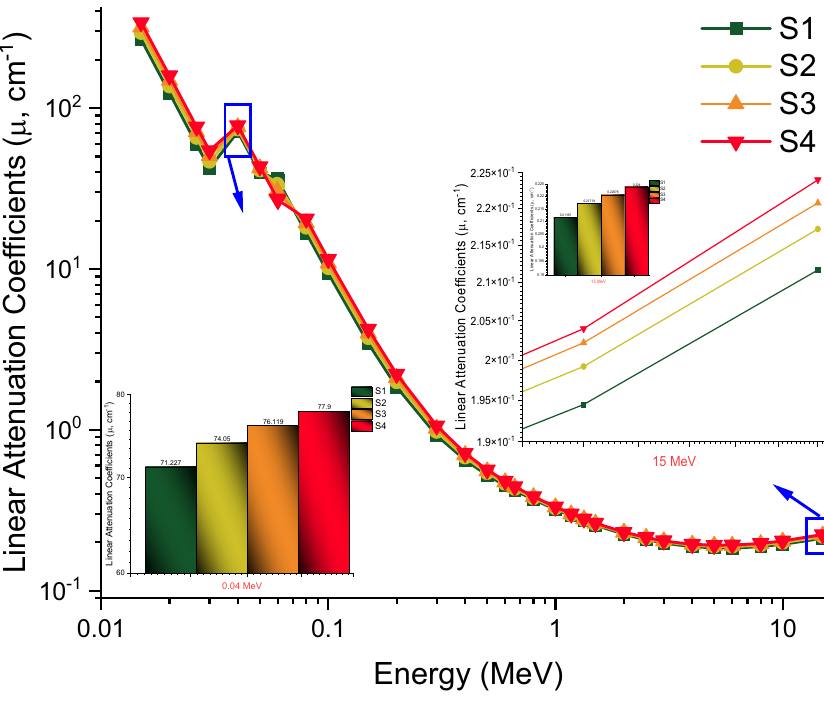
Figure 3: Variation in linear attenuation coe ffi cient ( cm − 1 ) with photon energy ( MeV ) for all S1 – S4 glasses.